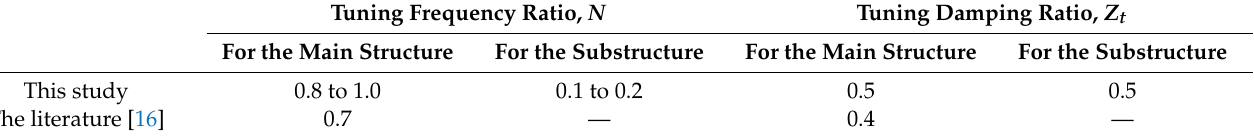
Table 2. Comparison between the recommended values of this study and the optimal values reported in the literature